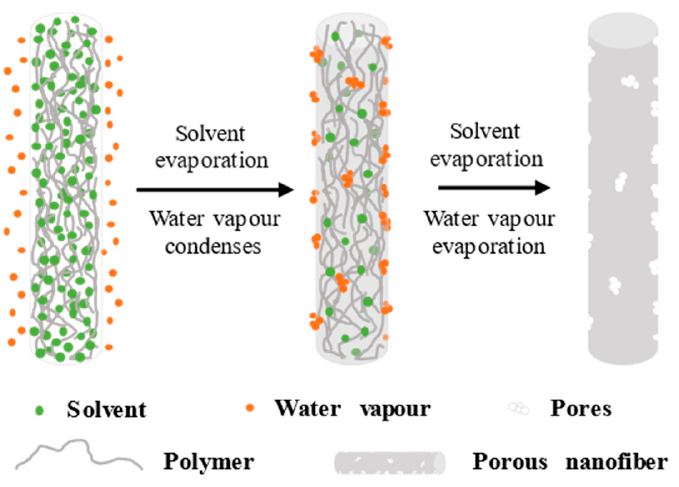
Figure 2. Schematic of the pore − forming mechanism of BFs.